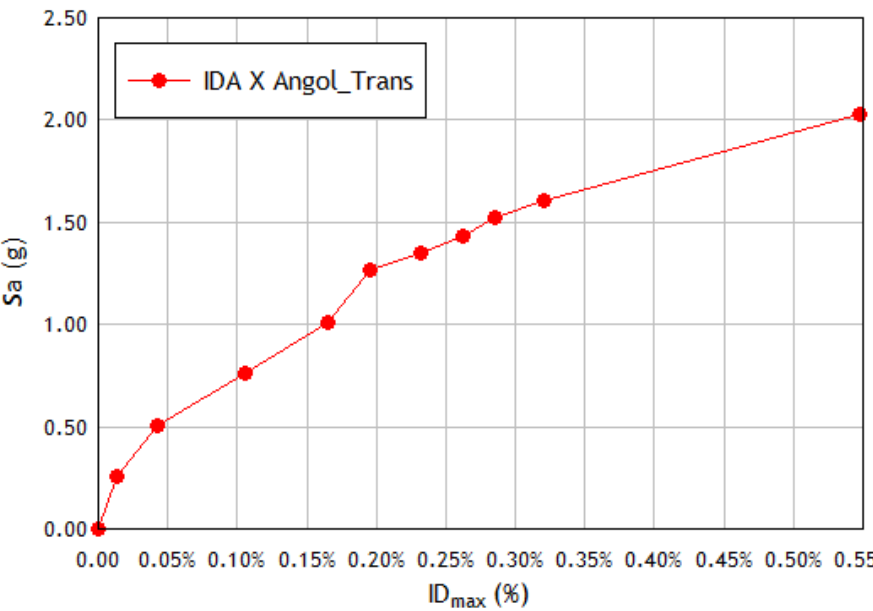
Figure 8. Standard IDA curve in the X direction of the structural model, subjected to the transversal component of the seismic event recorded at Angol station.